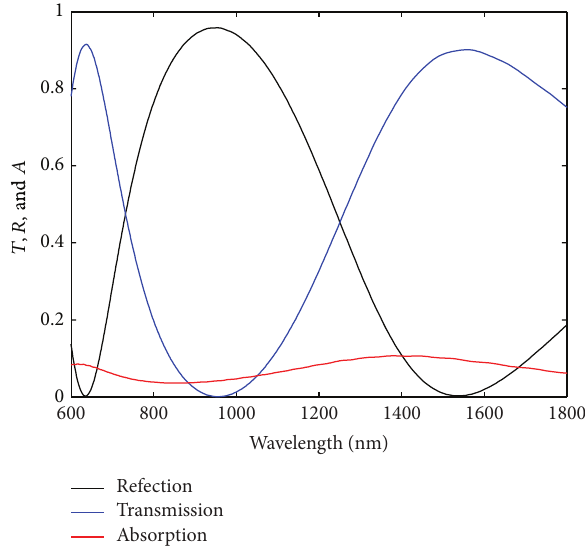
Figure 2: Reflection (transmission and absorption) spectra of fundamental frequency wave through a triangular lattice perforated gold